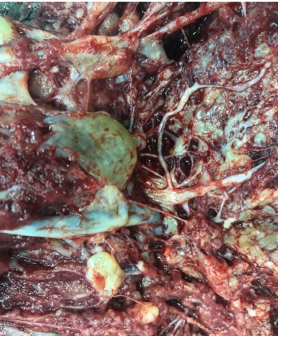
Figure 6. Hydropic cysts with features for partial hydatiform mole.